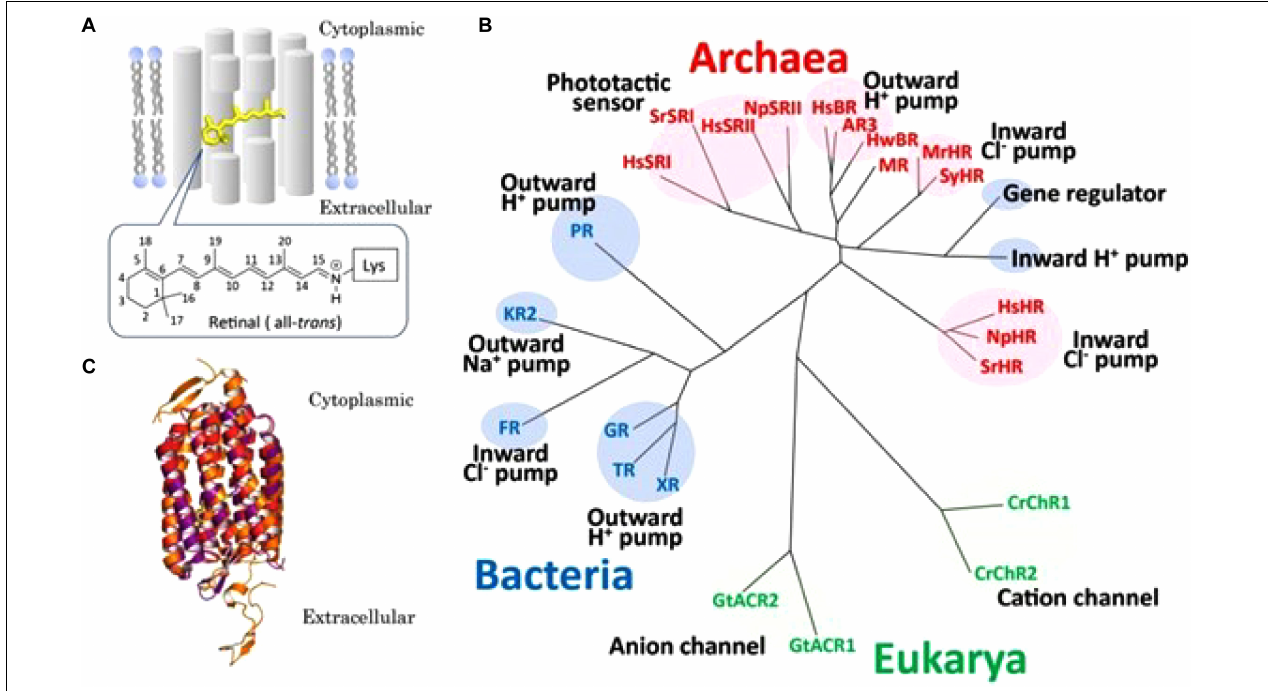
FIGURE 4 | Overview of microbial rhodopsins. (A) Schematic drawing of a seven-transmembrane microbial rhodopsin, where an all- trans retinyl chromophore (yellow) is covalently tethered to a specific Lys residue of the apoprotein opsin via a protonated Schiffbase linkage. Numbers on the retinal represent the cognate carbon atoms. (B) Phylogenetic tree of microbial rhodopsins constructed by ClustalW software program. Microbial rhodopsins are widely distributed throughout all domains of organisms, bacteria (blue), Eukarya (green) and Archaea (red), with a wide variety of biological functions (pumps, channels, and sensors). See text in original paper by Kaneko et al. (2017) for the abbreviations of the names of microbial rhodopsins. (C) Superposition of crystal structures of Halobacterium salinarum bacteriorhodopsin (purple) (HsBR; PBD ID1C3W), Natronomonus pharaonis sensory rhodopsin II (red) (NpSRII; PBD ID 1JGJ) and chimeric cation channel rhodopsin (ChR) from Chlamydomonas reinhardtii ChR-1 (CrChR1) and ChR-2 (CrChR2) (orange) (C1C2; PDB ID 3UG9). The retinal chromophore is colored yellow. Figure and legend borrowed from Kaneko et al. (2017) (Figure 1), Open